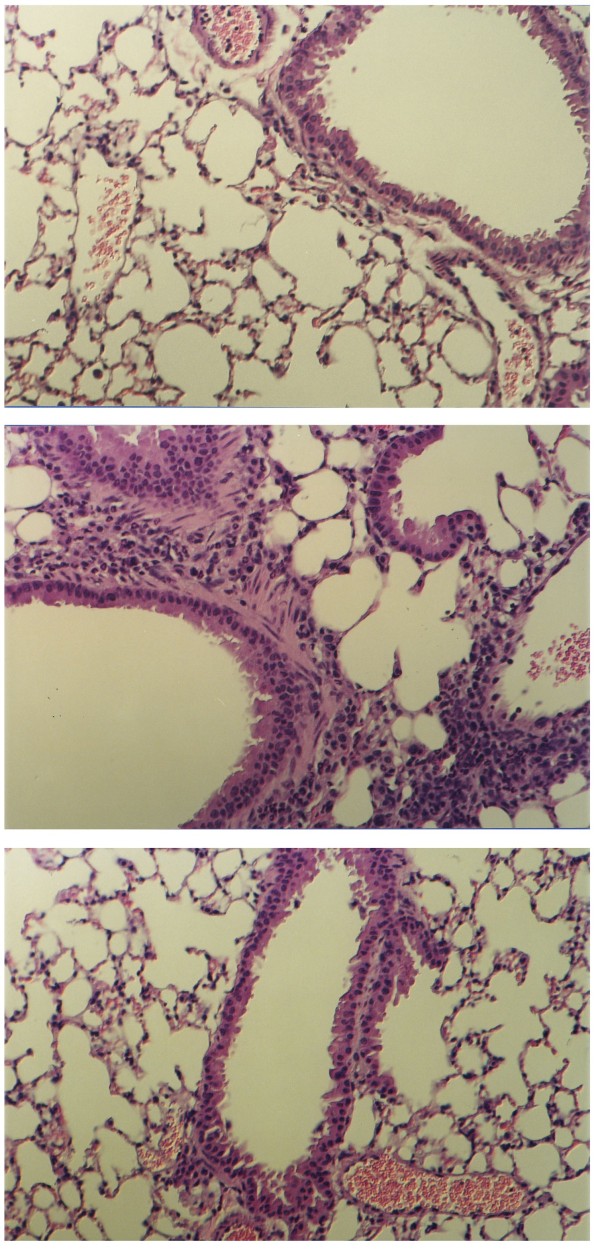
Lung histology samples in ovalbumin immunized mice. Top Panel: Control mice challenged with aerosolized saline; there is no evidence of peribronchial and perivascular inflammation. Middle Panel: Mice challenged with aerosolized ovalbumin; marked peribronchial and perivascular inflammation is seen with eosinophil infilteration. Bottom Panel: Ovalbumin challenged mice after pretreatment with nebulized heparin tetrasaccharide; reduced peribronchial and perivascular inflammation. Hematoxylin and eosin stain ( × 64 magnification).